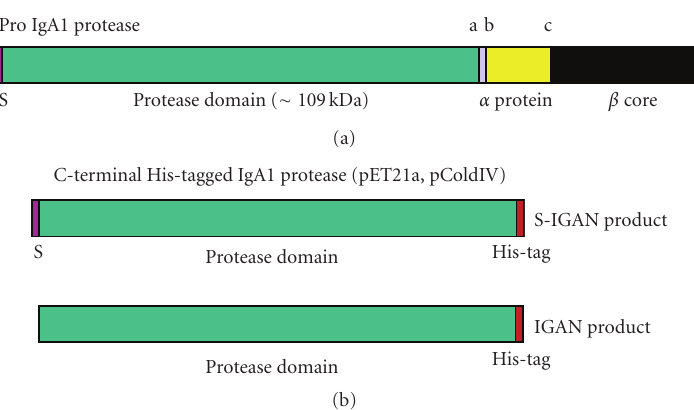
Figure 1: IgA1 protease expression constructs. Only the IgA1 protease domains with or without the signal peptide were cloned into pET21a and pCold IV expression vectors. S: signal peptide for targeting to the periplasm; a, b, c: the three IgA1 protease self-cleavage sites delineating the di ff erent